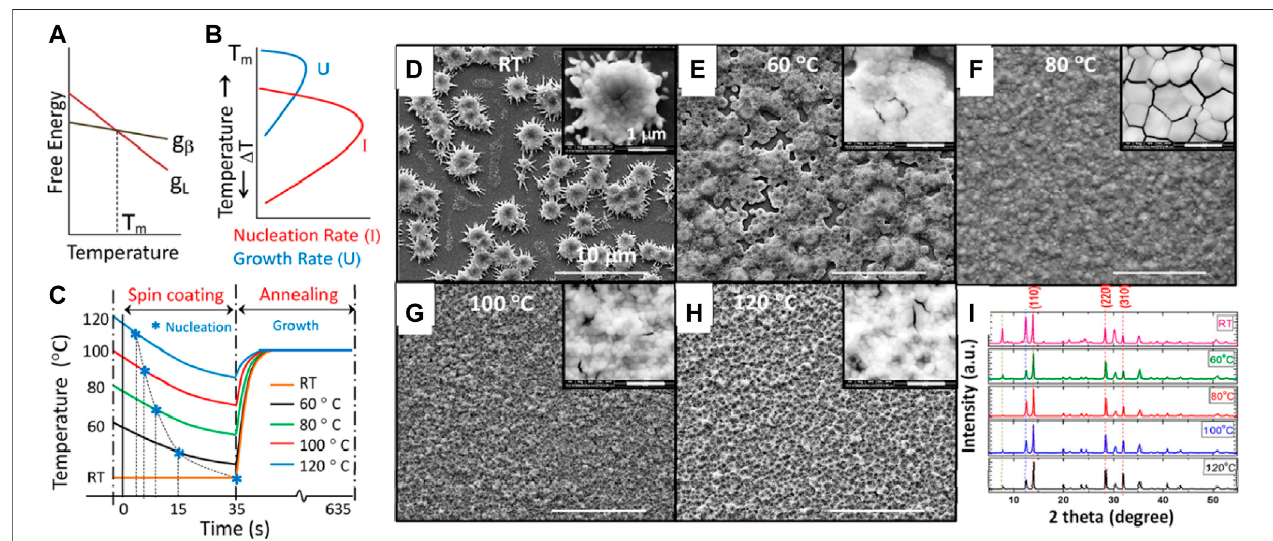
FIGURE2|(A) Schematicvariationofthefreeenergyofamaterialinaliquid(g L )andcrystallineform(g β )asafunctionoftemperature. (B) Temperaturedependence ofnucleationrate(I)andgrowthrate(U).AdoptedwithpermissionfromRaghavan,2011.Copyright2011Prentice-HallIndia. (C) Expectedtemperaturevariation(nottrue scale) of the substrates during spin coating and annealing (assuming Newtonian cooling during spin coating and at thermal equilibrium during annealing). Blue asterisks indicate the nucleation points where yellow-colored fi lms turn dark-colored. (D – H) FESEM images of the perovskite fi lm fabricated at different substrate temperatures. The scale is 10 μ m. Inset: zoomed FESEM images of each fi lm with the scale bar of 1 μ m. (I) XRD of the perovskite fi lm fabricated at different substrate temperatures. Peaks indicated by red dotted lines (~14 ° , ~28.5 ° , and ~32 ° ) correspond to the characteristic MAPbI3 peak. Peaks indicated by the blue dotted line (~12.6 ° ) correspond to the lead iodide peak, and black dotted line (~7.9 ° ) corresponds to the lead acetate peak. Reproduced with permission (Srivastava et al., 2018). Copyright 2018, American Chemical Society.